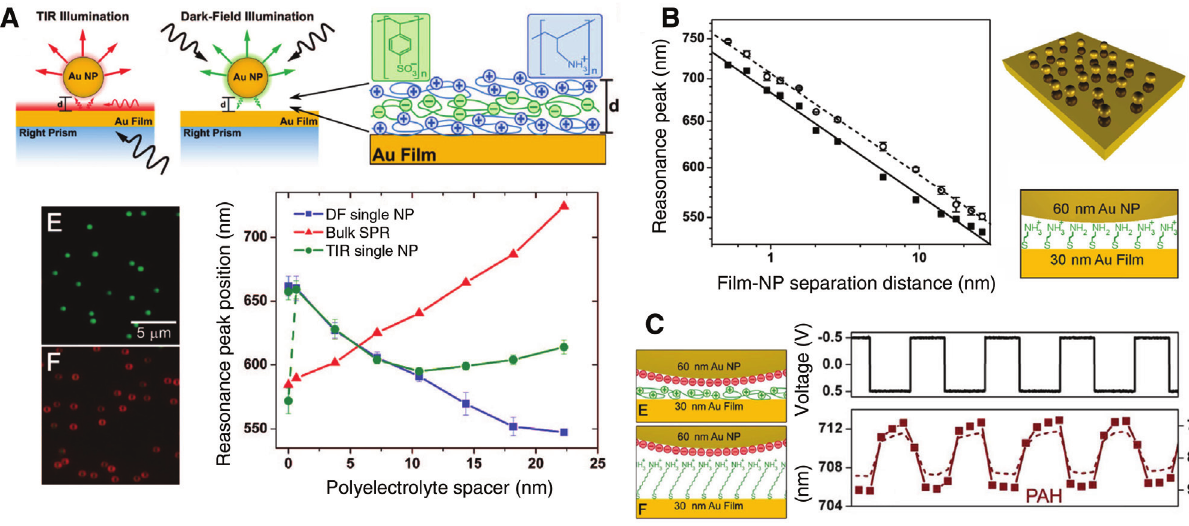
Figure 16: (A) System investigated in [38], where a gold nanosphere, separated from a gold film by a small layer of polyelectrolyte (PE), is studied either in total internal reflection (TIR) or by dark-field (DF) spectroscopy. The far-field image of the nanospheres excited in DF are shown on E and F, bottom-left, whereas the bottom-right plot shows the evolution of the different plasmon modes wavelengths with the spacer thickness, both in TIR and DF configurations; (B) evolution of the plasmon wavelength (open circles: scattering, closed squares: extinction) of an assembly of 60 nm-diameter gold nanospheres separated from a 30 nm-thick gold film by a SAM layer of thickness ranging from 1 Å to 20 Å and PE layers up to 27 nm thick, from [39]; (C) shift of the plasmon wavelength of a system similar to (2), where the thickness of the spacer is triggered by an external electric field, inducing a detectable LSP shift up to ± 3 nm, from [40]. Reprinted with permission from Nano Lett., 2008, 8 (8), pp 2245–2252, ACS Nano, 2012, 6 (10), pp 9237–9246 and Nano Lett., 2012, 12 (4), pp 1757–1764.